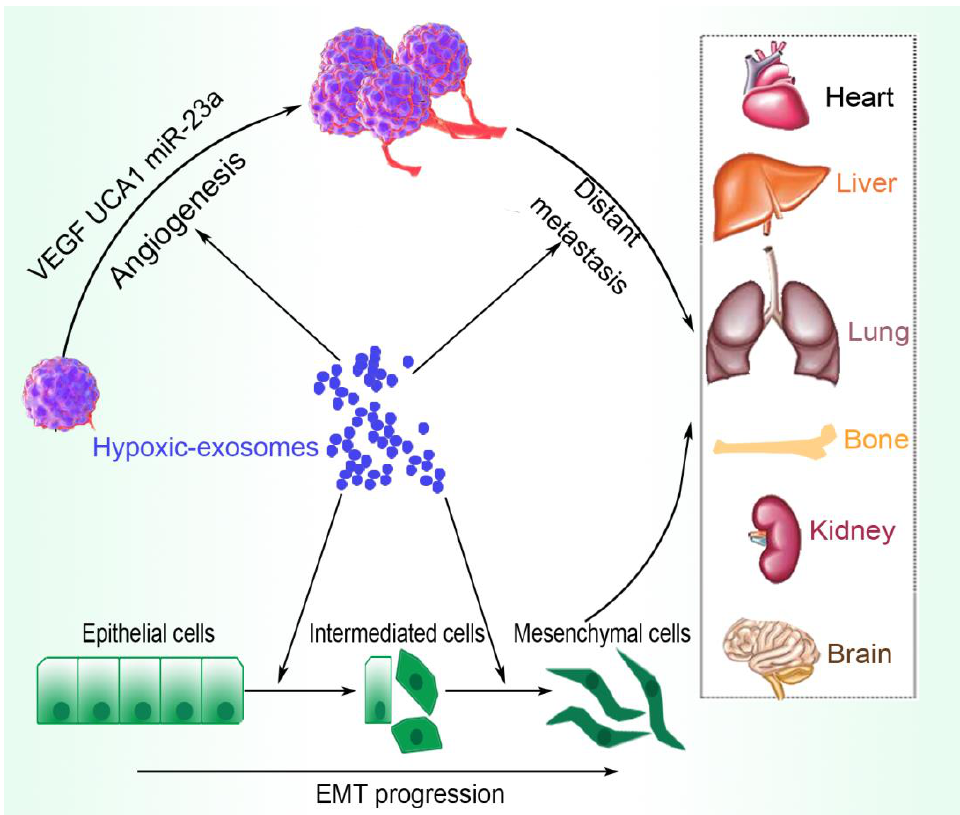
Figure 1. An overview of the promoting effects of the hypoxic-tumor-derived exosome. Tumor-derived exosomes transfer regulatory particles, such as VEGF, UCA1, and miR-23a, that induce angiogenesis and enhance tumor growth. The expressed exosomes also trigger EMT, which together contribute to enhanced metastasis.